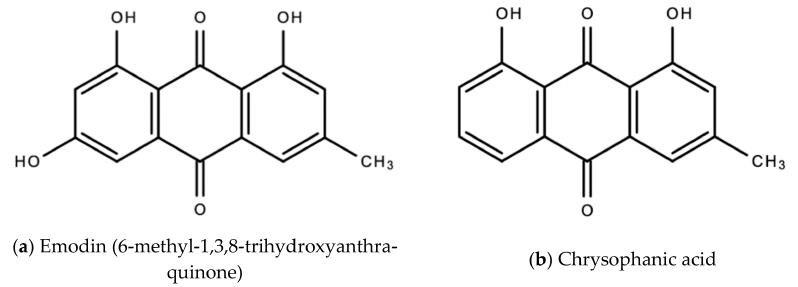
Figure 3. Chemical structures of some bioactive molecules found in A. vera